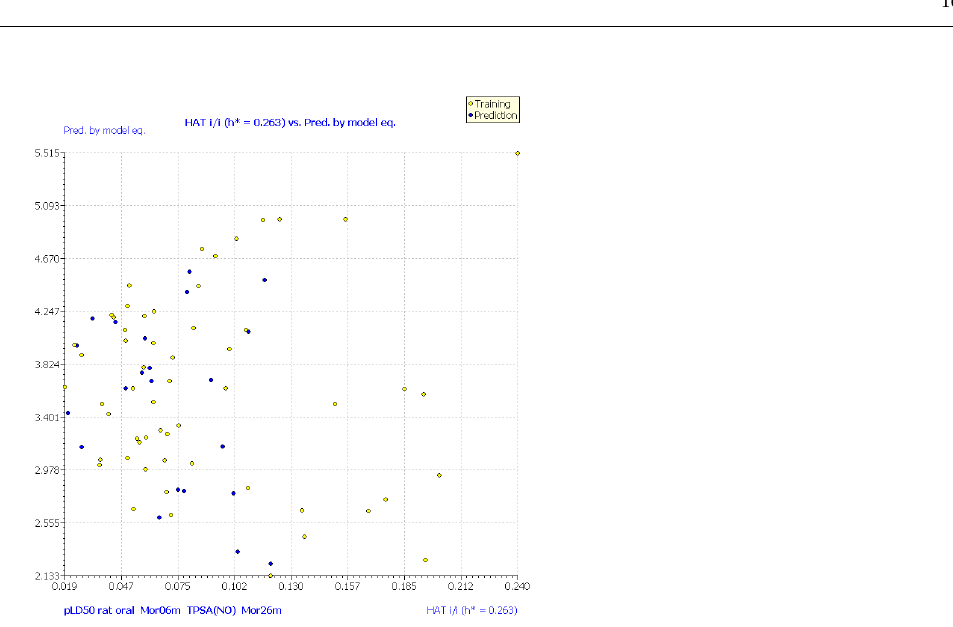
Figure 4. Insubria plot predicted by the MLR1 model (yellow circles-training compounds, blue circles-test compounds).